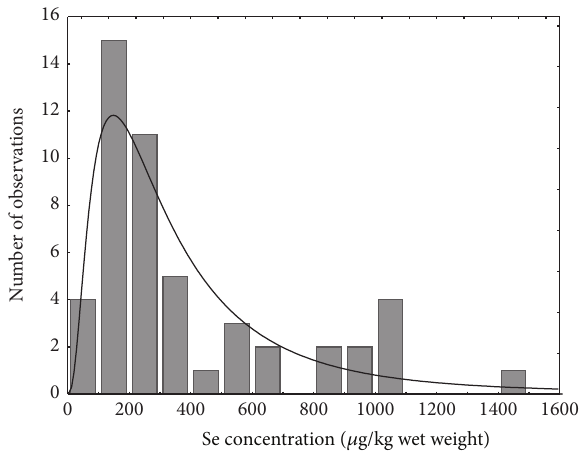
Figure 2: Statistical summary of whole body Se concentrations ( 𝜇 g kg −1 wet weight) for insects with different feeding habits col- lected from the Dniester River Valley (symbol: median; box: 25th and 75th percentiles; whiskers: minimum and maximum). An aster- isk represents a significant difference ( 𝑃 < 0